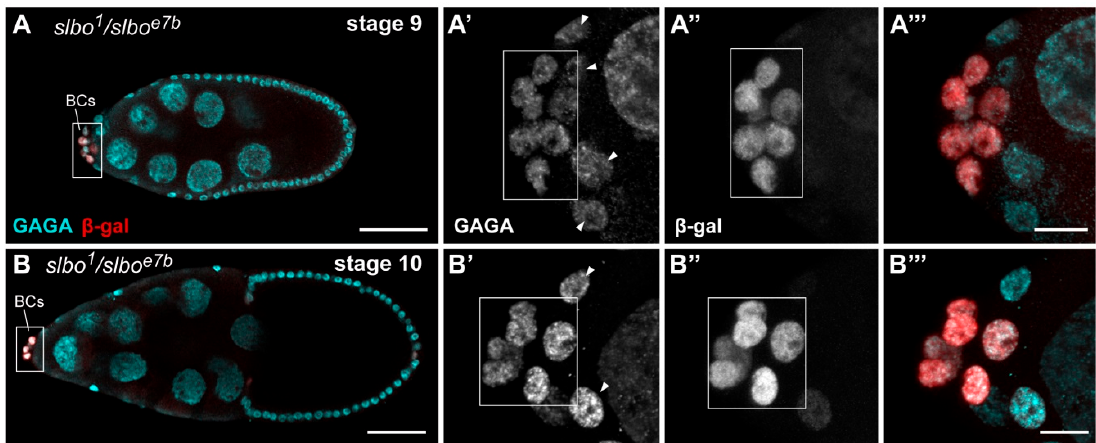
Figure 5. Expression of GAGA is not affected in slbo mutant egg chambers . Immunodetection of β -galactosidase (red) driven by the slbo-LacZ reporter ( slbo 1 enhancer trap mutation) and the GAGA protein (cyan) in slbo 1 / slbo e7b mutant egg chambers at stages 9 ( A ) and 10 ( B ). The regions of BCs are marked by dotted frames and are enlarged in A’ – A’’’ and B’ – B’’ ’, in which single cyan (A’ and B’) and red (A’’ and B’’) channel images as well as merge images (A’’’ and B’’’) are shown. Scale bar is 50 µm and 10 µm for A, B, and the enlargements, respectively. As can be seen in (A’) and (B’), the amount of GAGA in slbo mutant BCs is not decreased compared to the adjacent follicular cells (marked with arrowheads).